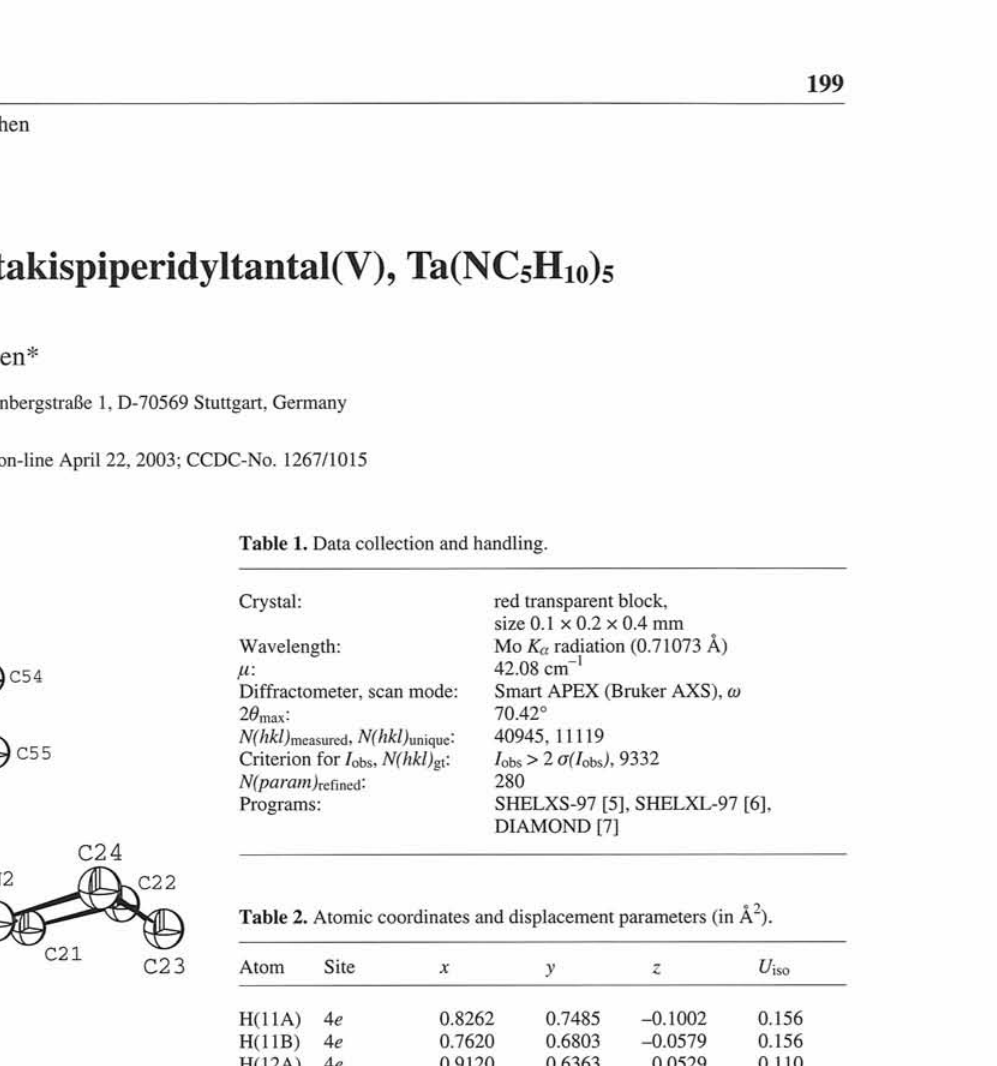
Table 2. Atomic coordinates and displacement parameters (in À 2